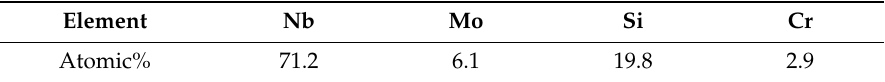
Table 1. Chemical composition of the initial alloy ingot (at